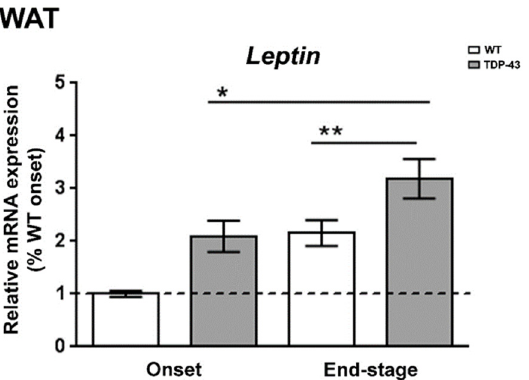
Figure 1. Alterations in leptin expression in the WAT in TDP-43 A315T mice. Leptin mRNA expression was assessed by RT-qPCR in TDP-43 A315T mice compared to age-matched WT littermates at both onset and end-stage of disease. Values are expressed as the mean ± SEM for the different groups (n = 5 per genotype/stage of disease). Comparison between groups was performed by two-way ANOVA followed by Dunnett’s post hoc test to compare all groups with WT onset stage, while Tukey’s post hoc test was used for multiple comparisons between all groups, where * p < 0.05 vs. WT onset stage; ** p < 0.05 vs. WT end-staged. Abbreviations: WAT, white adipose tissue.